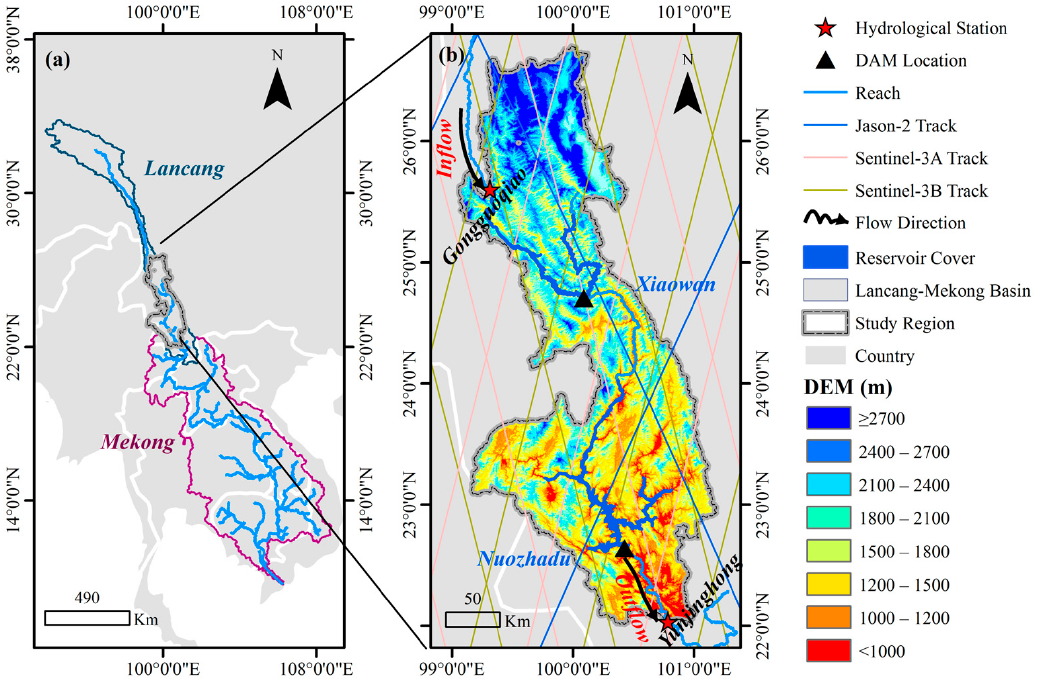
Figure 1. Study area. ( a ) The geographical location of the Lancang-Mekong Basin. ( b ) Zoomed-in map showing the base map of the cascade Xiaowan and Nuozhadu reservoirs along with dam locations, in situ discharge stations, DEM, the ground tracks of sentinel-3 A/B, and Jason-2. Abundant water resources and unique water head differences provide favorable conditions for the reservoir. There are more than 55 large reservoirs in the Lancang-Mekong River basin and 11 large reservoirs in the Lancang River basin. These projects